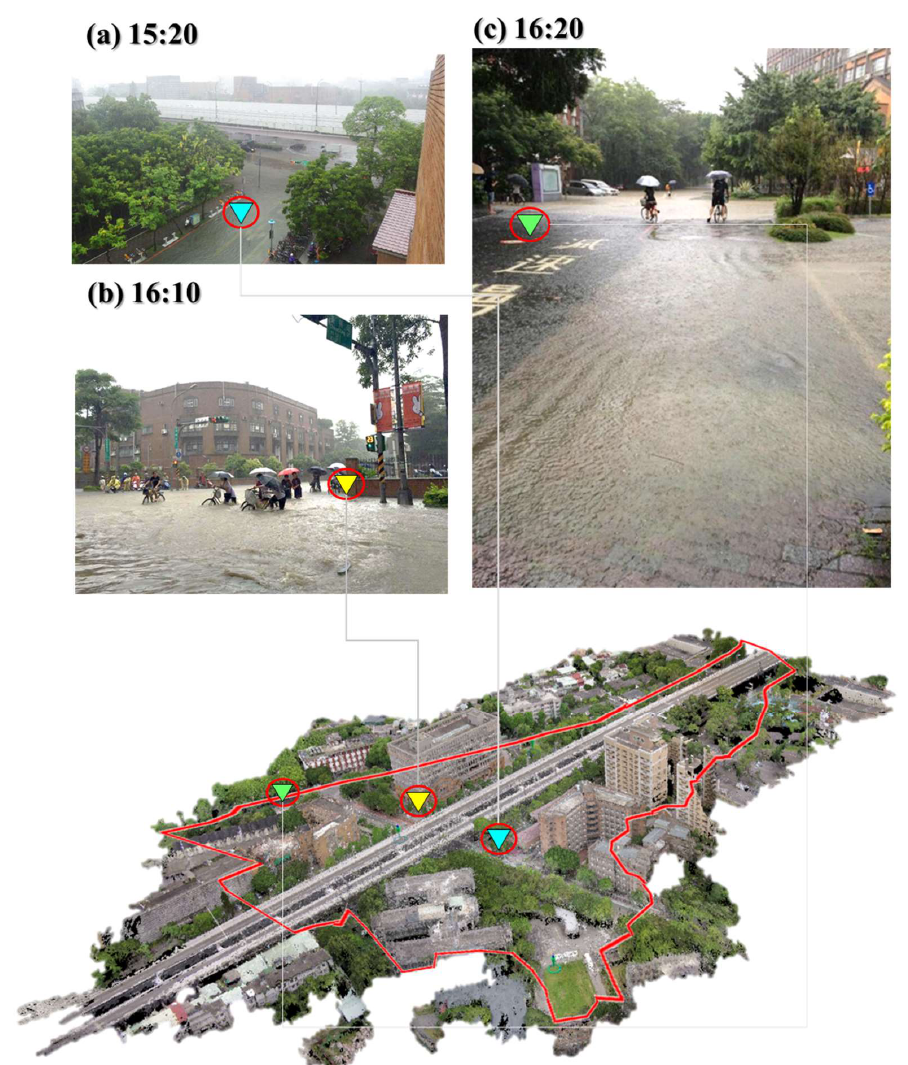
Figure 5. Image-based VGI illustrating photograph shooting locations and acquisition times of ( a ) 15:20, ( b ) 16:10, and ( c ) 16:20 through the point cloud.